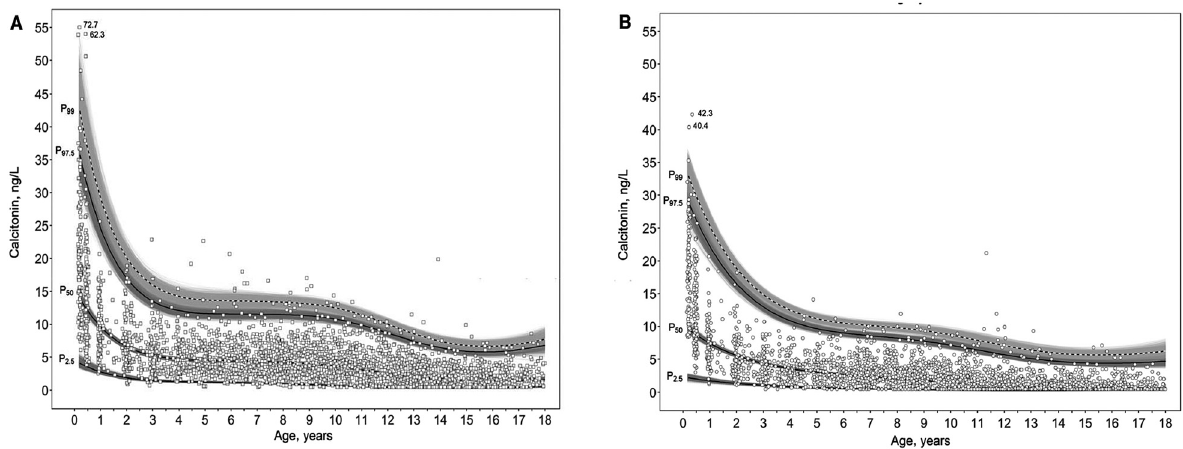
Figure 3: Serum Ct measurements of healthy boys (A) and girls (B) depending on age. Asolidlineindicatesthe2.5th,50th,and97.5thpercentiles.The99thpercentilewasshownasadashedline.Re-samplinglevelsweremarked by the shaded areas around the percentiles. With permission from ref.